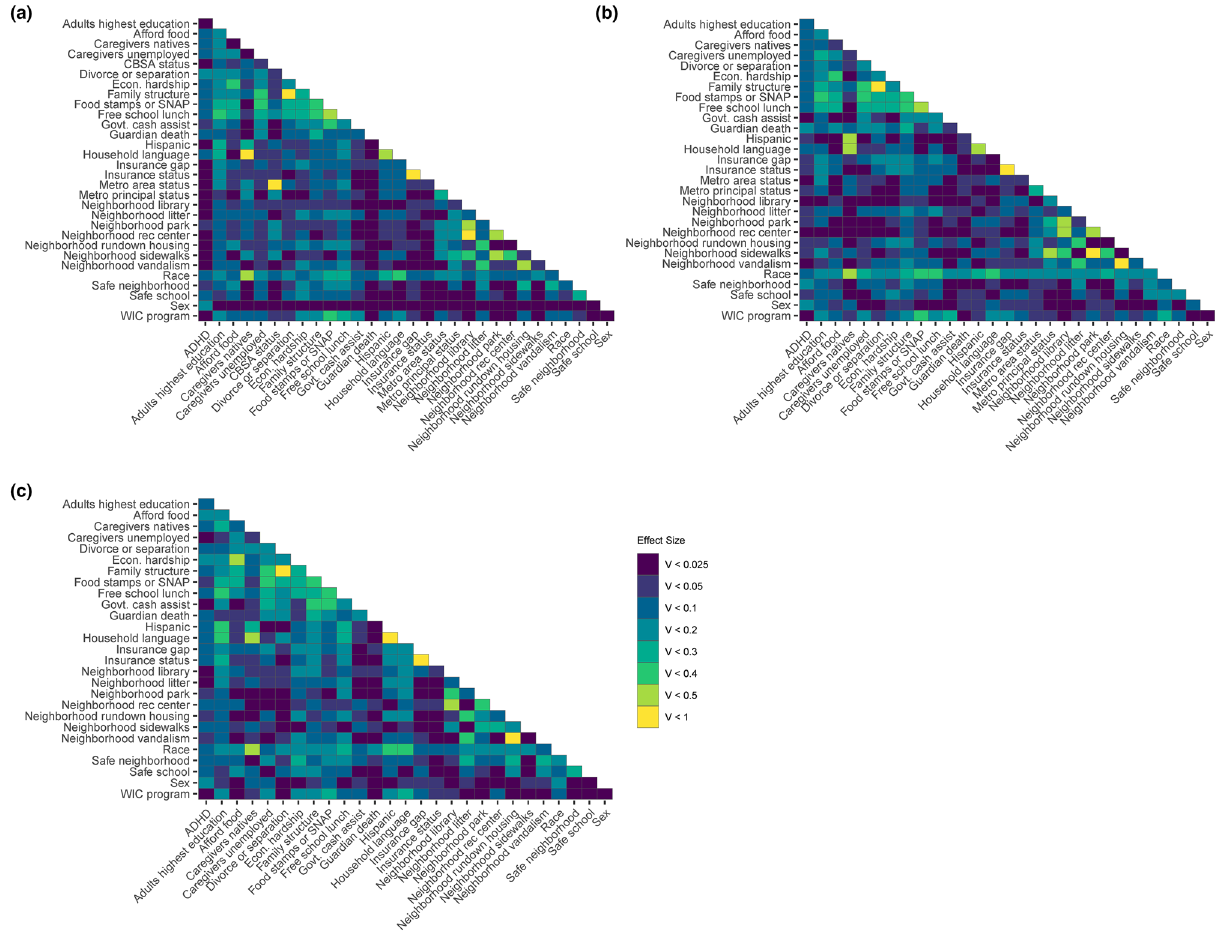
Figure 6. Matrices of Cramér’s V values between ADHD diagnosis, SES factors, and demographics ( a ) nationwide (n = 52,065), ( b ) in Louisiana only (n = 1,084), and ( c ) in Nevada (n = 999) only. Darker colors indicate lower Cramér’s V effect sizes and yellow indicates the highest Cramér’s V effect